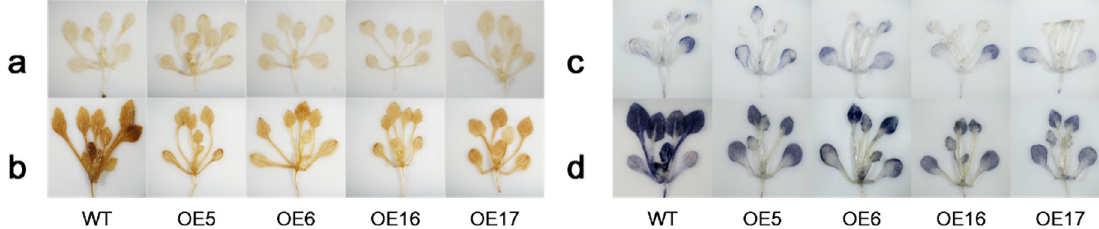
Figure 7. Detection of ROS of FaHsfC1b ‐transgenic Arabidopsis and WT. Plants stained by DAB ( a ) and NBT ( c ) under normal conditions. Plants stained by DAB ( b ) and NBT ( d ) after heat stress at 37 °C for 1 h.